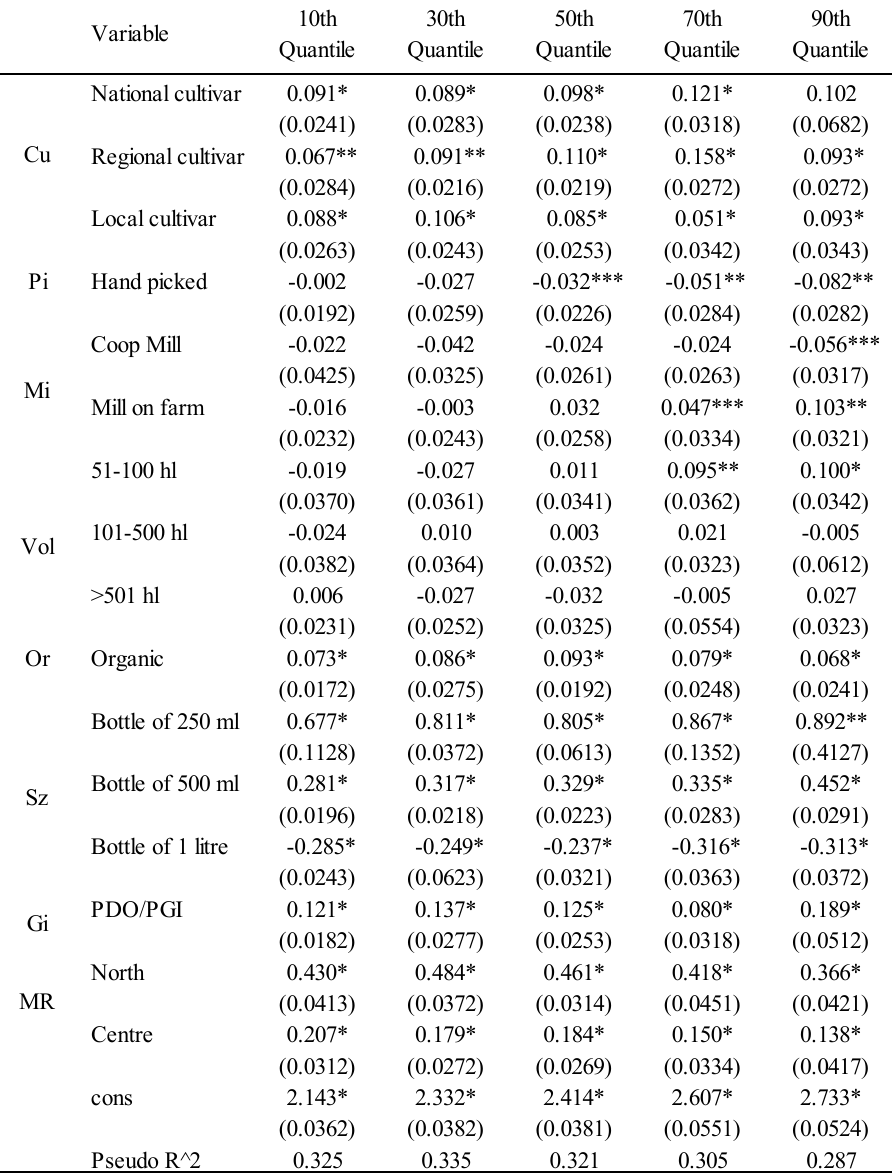
Table 2. QRM estimation results for various conditional